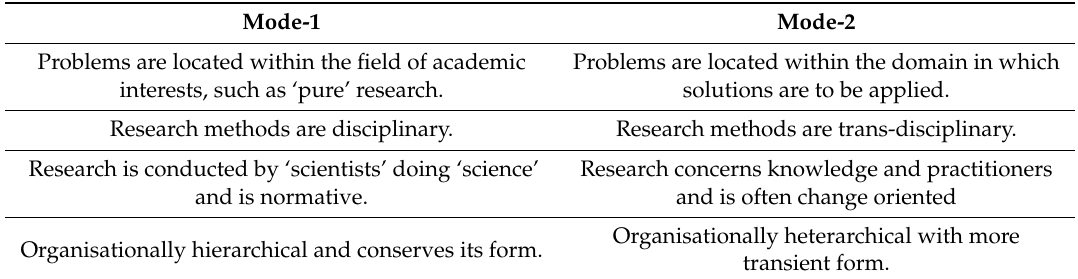
Table 1. Comparing Mode-1 and Mode-2 science (source: Gibbons et al. 1994, p.